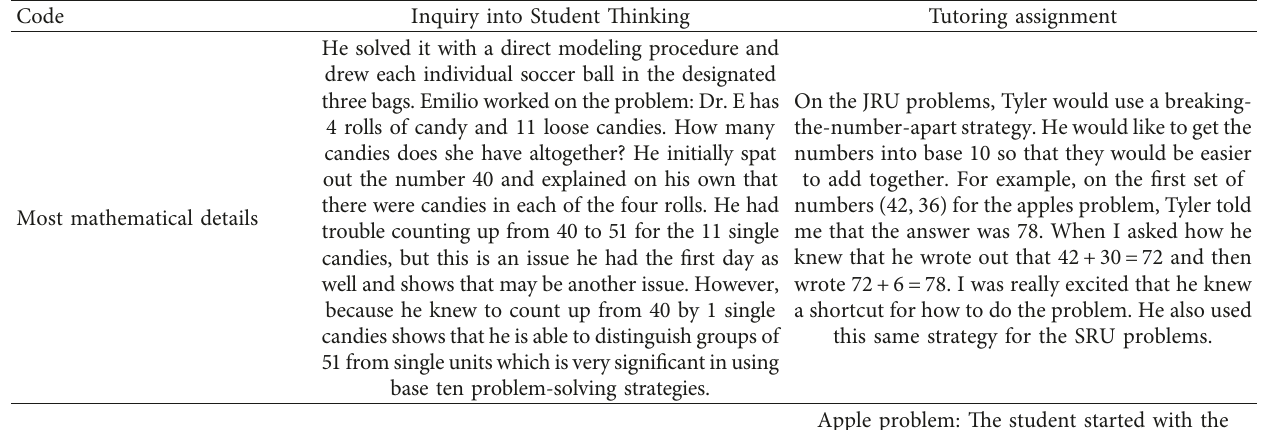
Table 2: Examples of responses coded as most, some, and lack of mathematical details.